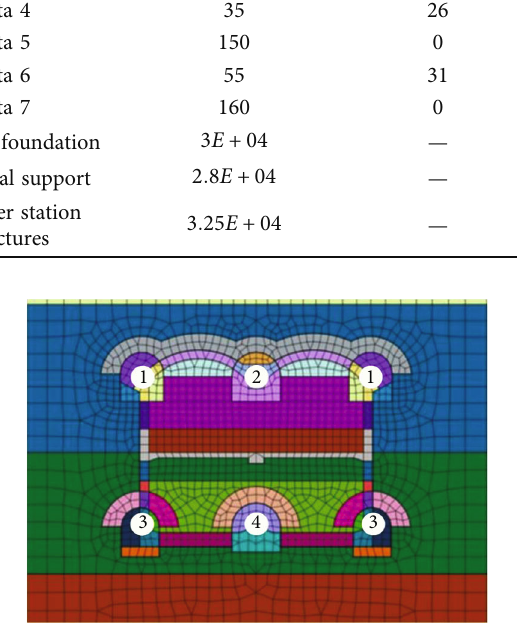
Figure 5: Sequence of pilot hole